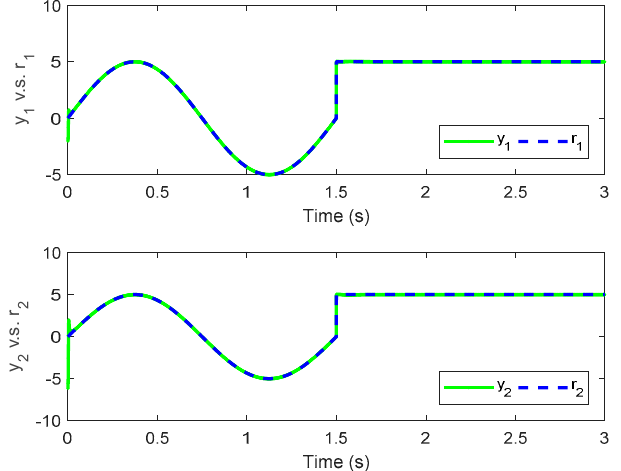
Figure 6. Error between unknown and estimated perturbations.